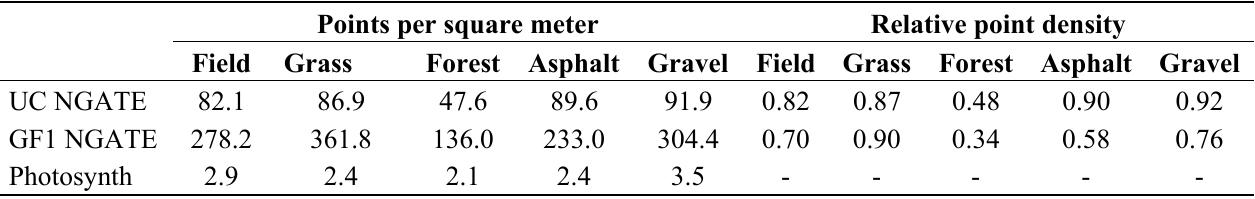
Table 2. Points per square meter and relative point densities evaluated in different objects in 3 m × 3 m areas. The point clouds were from UltraCamXp by NGATE (10 cm point interval), GF1 by NGATE (5 cm point interval) and GF1 by